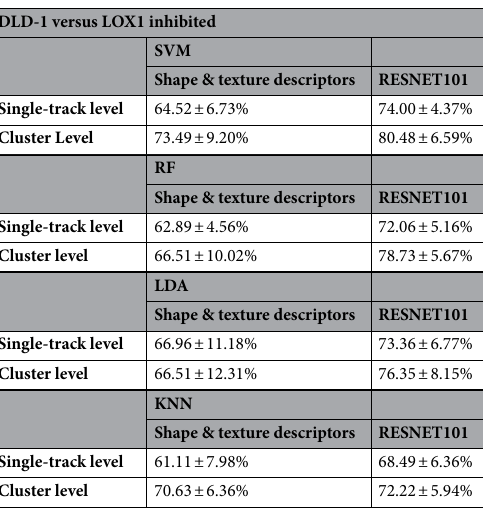
Figure 2. Confusion matrices of the classification task in case study 1 using RESNET101 and SVM classifier. Single-track results (left) and cluster results (right). Third column represents in turn from top to bottom: ratio of DLD1 correctly recognized, ratio of LOX1 inhibited correctly detected, unbalanced accuracy (ratio of the sum of true positives and true negatives over the total number of instances). DLD-1 versus LOX1